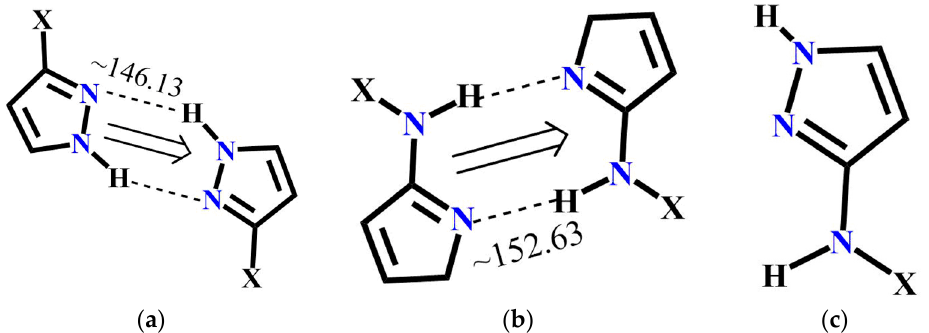
Figure 7. Pyrazole fragments used to perform CSD molecular complementarity search ( a ) Average bond angle for A (22 structures in CSD); ( b ) average bond angle for B (35 structures in CSD) and ( c ) pyrazole fragment for CSD search.